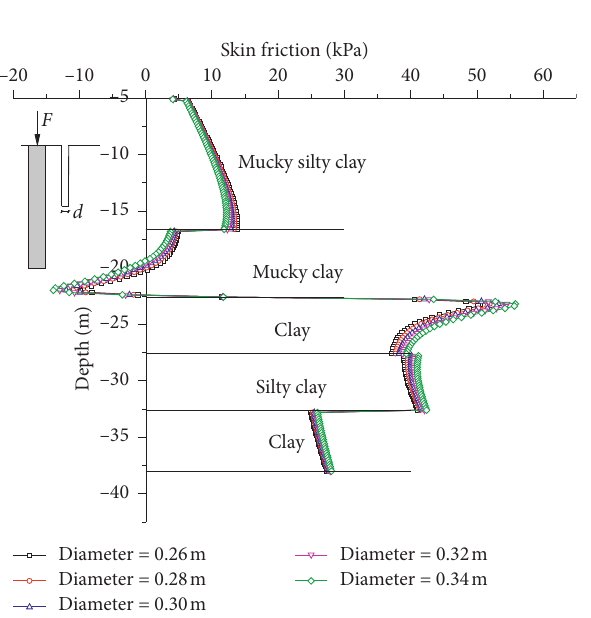
Figure 8: Variations of skin friction of the existing foundation pile at different segments under the impact of different borehole diameters.